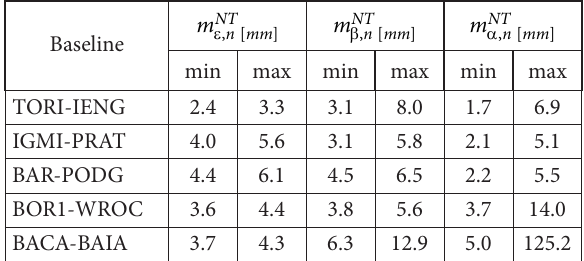
Table 3. Extreme values of epoch-wise standard deviations estimates for the coordinate u and the daytime ( DT ) period Baseline